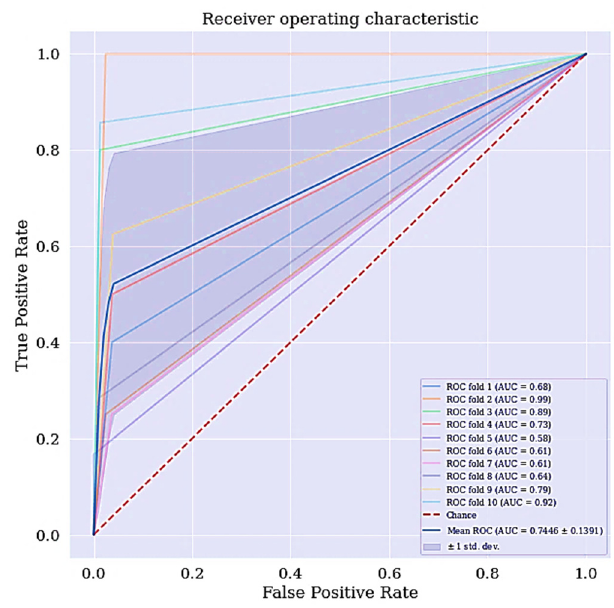
Figure 4. ROC curve for DT without RFE and SMOTETomek.